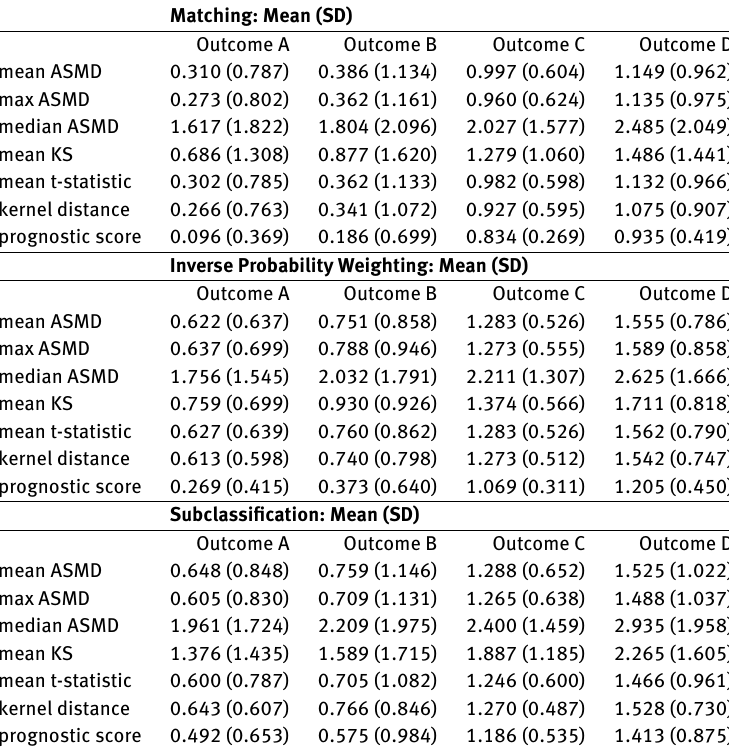
Table 4: Bias and standard deviation of the estimated